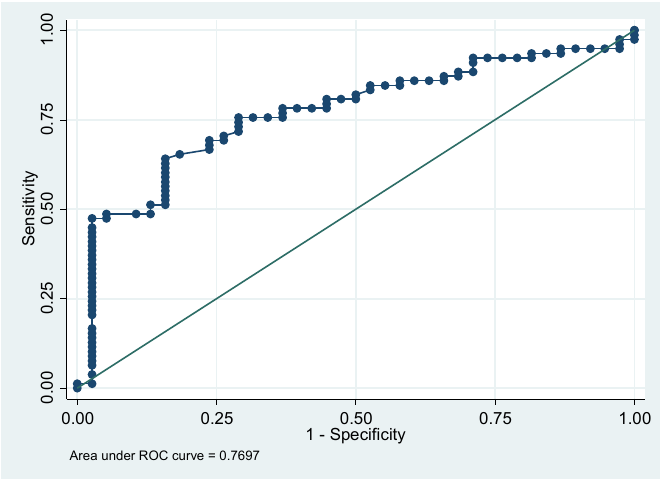
Figure 3. To assess the capacity of muscle ultrasound (MUS) to predict skeletal muscle index (SMI) using bioelectrical impedance analysis (BIA), we performed ROC analysis and the AUC was 0.77.